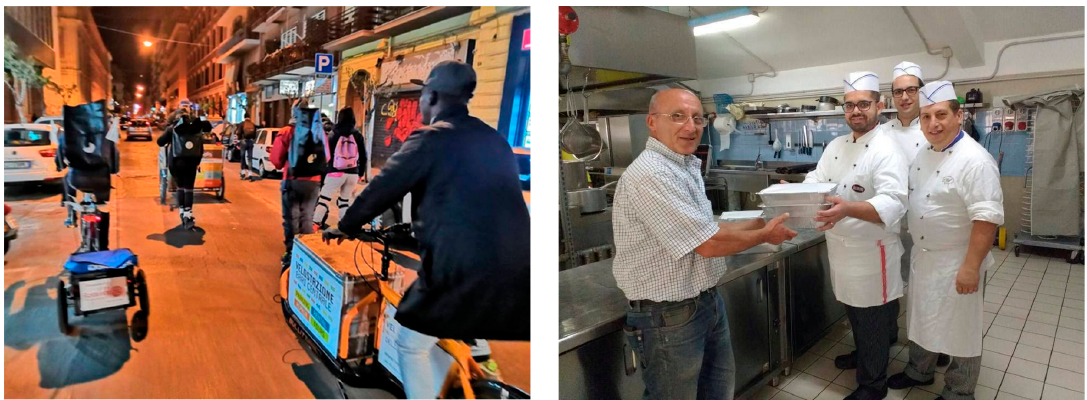
Figure 4. AP volunteers during SF recovery actions . Source: Avanzi Popolo 2.0.